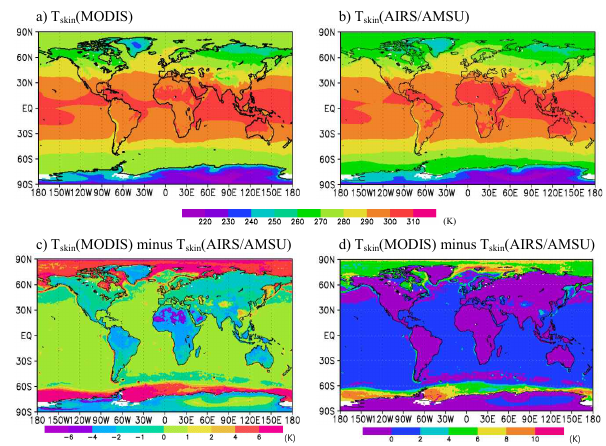
Fig. 1. Climatological annual surface skin temperatures (K) dur- ing the period from September 2002 to August 2011. (a) T skin Figure 1. Climatological annual surface skin temperatures (K) during the period from 3 (MODIS), (b) T skin (AIRS/AMSU), (c) and (d) the difference be- September 2002 to August 2011. a) T skin (MODIS), b) T skin (AIRS/AMSU), c) and d) the 4 tween T skin (MODIS) and T skin (AIRS/AMSU). Note that color difference between T skin (MODIS) and T skin (AIRS/AMSU). Note that color bars in Figs. 1c-d 5 bars in Fig. 1c–d have different have the different scales. 6